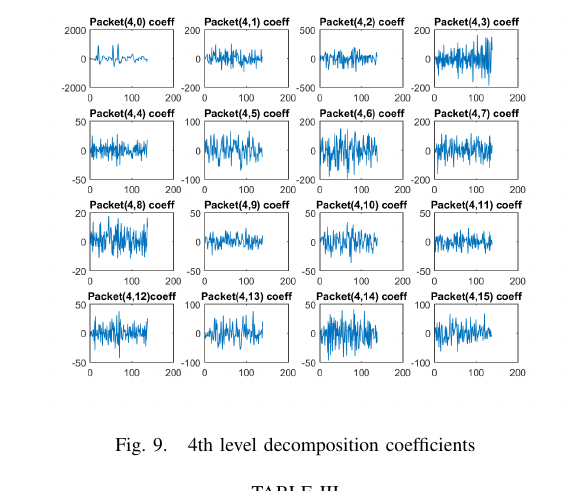
Fig. 6. 1st level decomposition coefficients